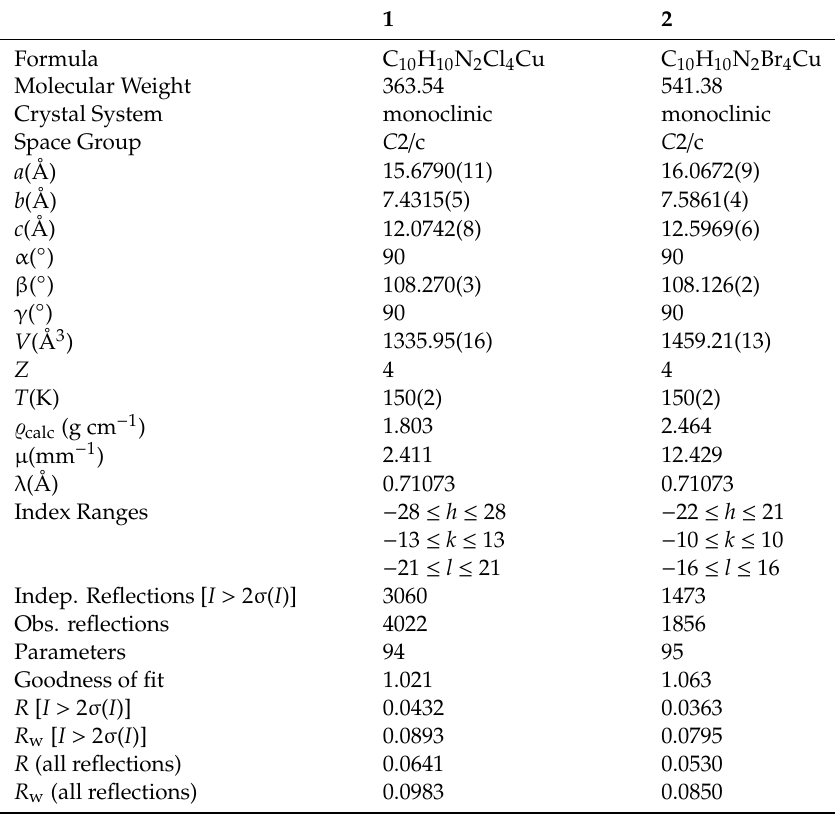
Table 1. Crystallographic information for 1 and 2 .